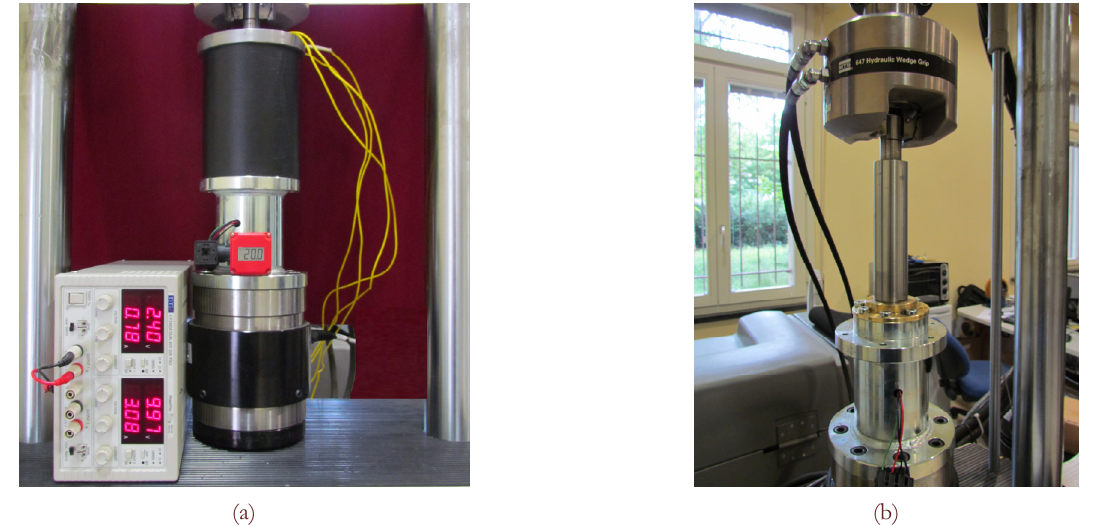
Figure 2: MR fluid insertion (a) central ferromagnetic piston fit (b) and full system mounted on the tensile machine. Shear stress in the MR